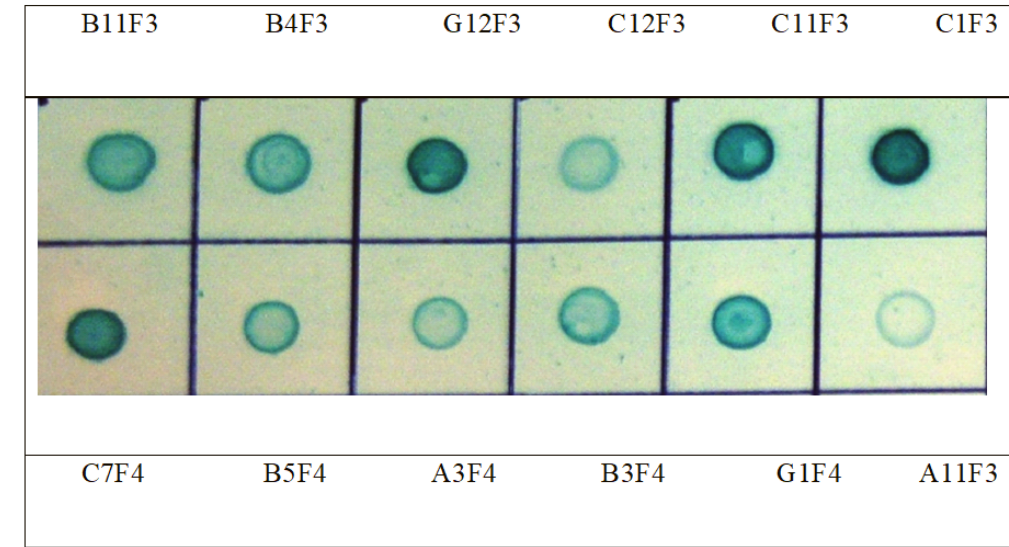
Figure 5. Immunoblot assay of binding of purified scFvs against their targets. Clones as designated in Figure